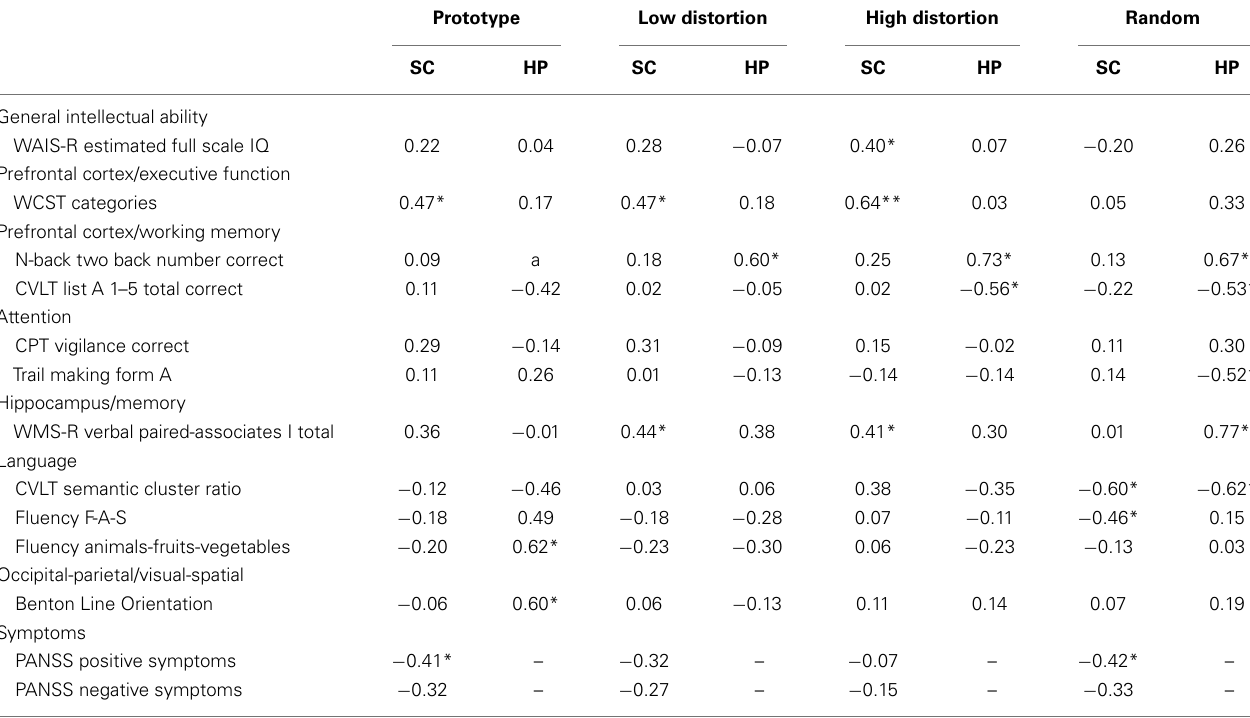
Table 4 | Correlations of category learning correct responding with cognitive and symptom